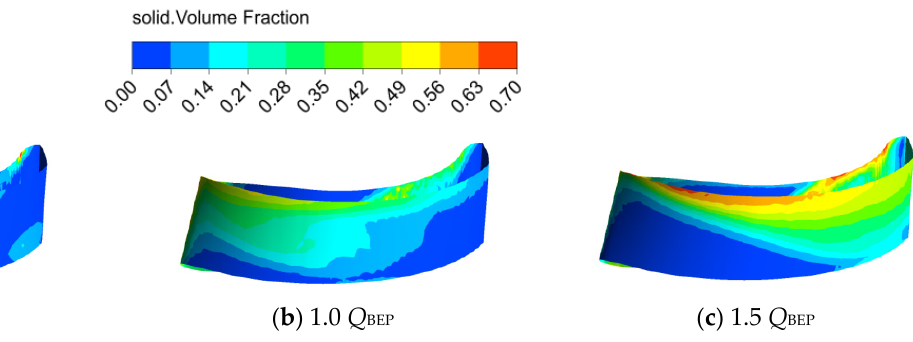
Figure 6. ( a – c ) Solid volume fraction distribution of the blade.